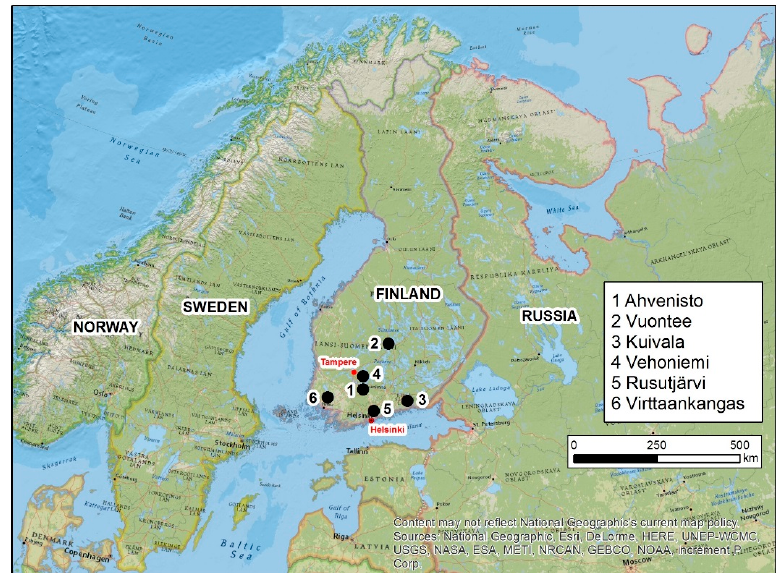
Figure 2. Names and locations of the studied MAR plants.